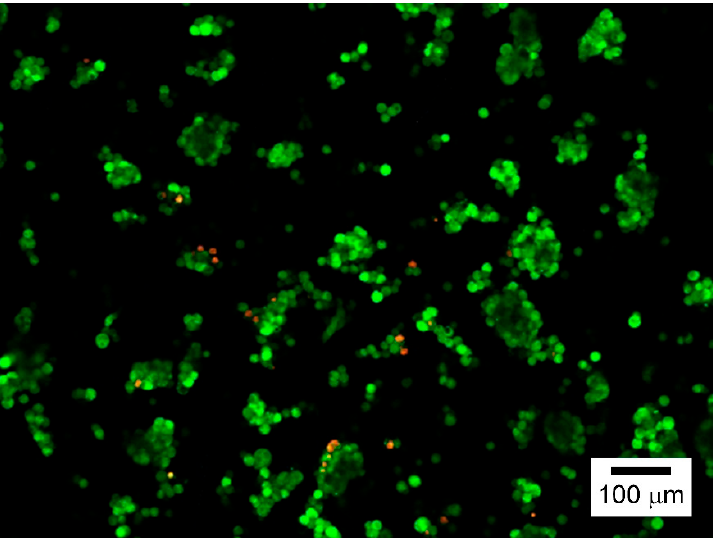
Figure 5. Live and dead cell assay results of the developed microfluidic chip for HepG2 cells (day